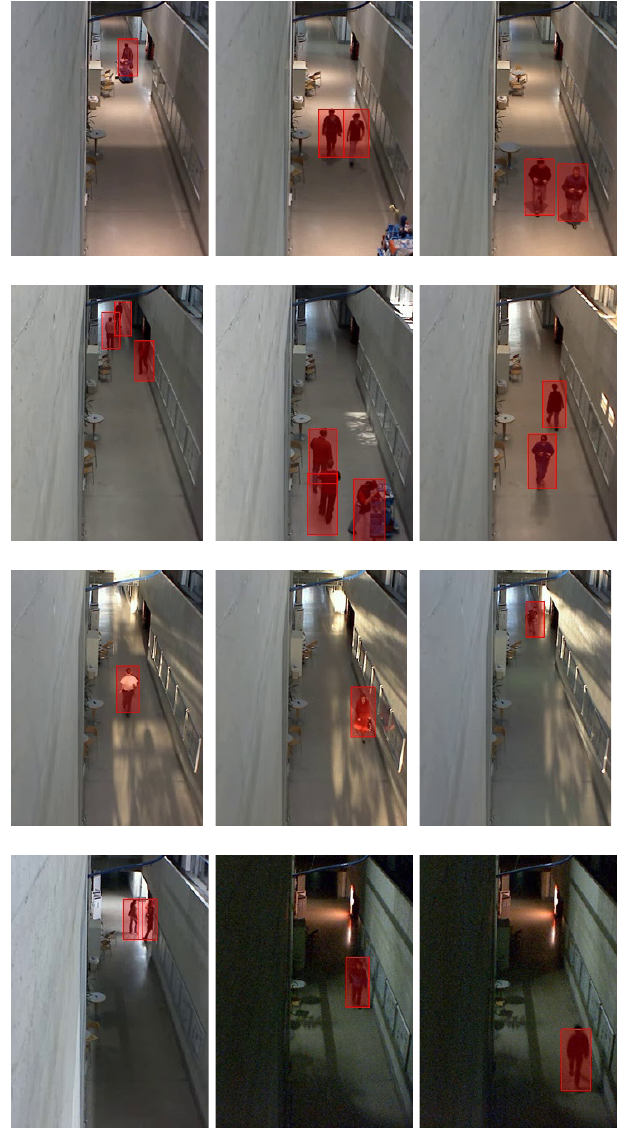
Figure 10. Illustrative detection results of the classifier grids obtained during long-term experiment. Each row corresponds to one time of day, morning, noon, afternoon, and night